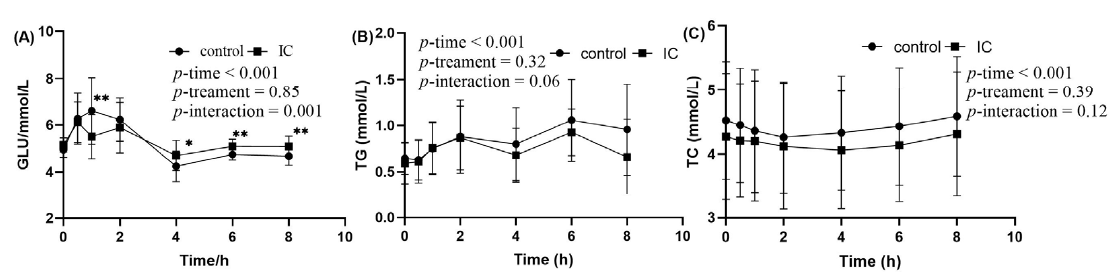
Figure 3. The concentration of glucose, TG and TC in serum sample within 8 h after meal. ( A ) postprandial serum glucose concentration; ( B ) postprandial serum TG concentration; ( C ) postprandial serum TC concentration. Data are expressed as mean ± SD (n = 18), with *: p < 0.05, **: p < 0.01.